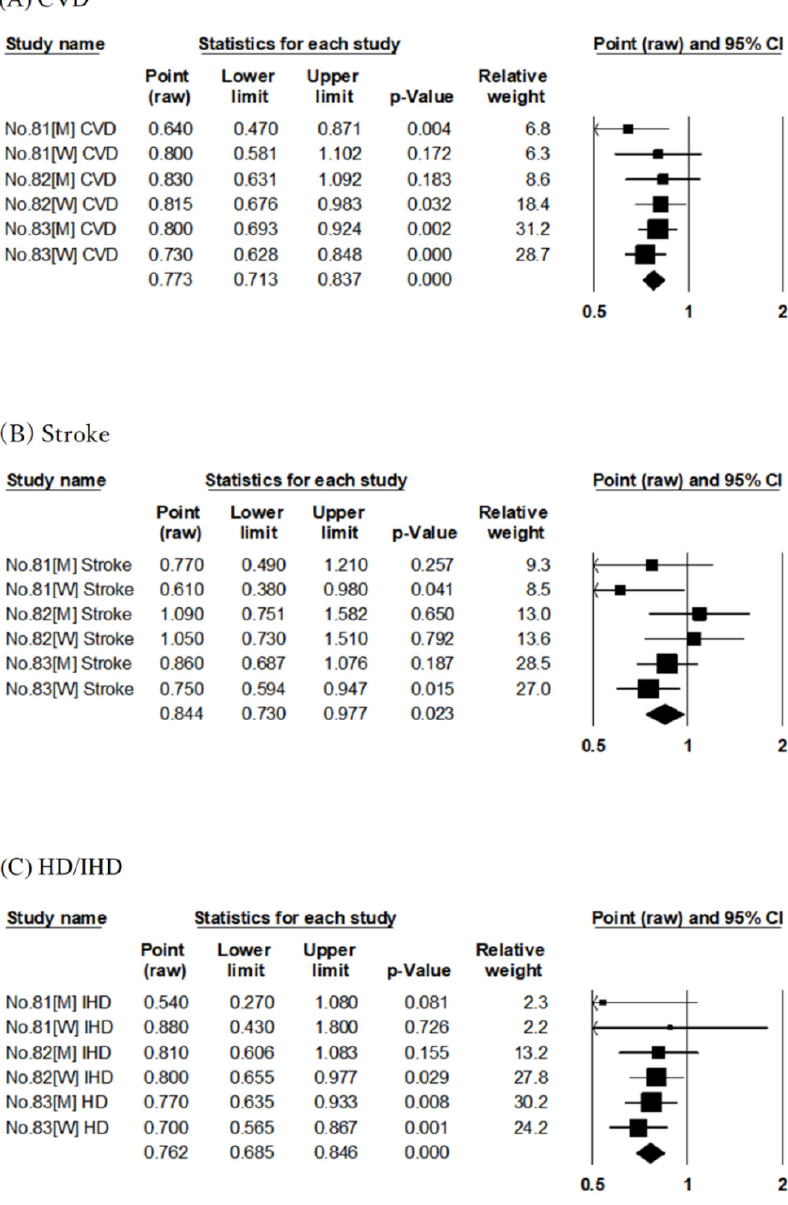
Figure 9. Meta-analysis of dietary fiber consumption and mortality risk. ( A – C ) show the association between dietary fiber consumption and CVD, stroke, and HD/IHD mortality risk, respectively. The area of each square is proportional to the study weight. Horizontal lines represent 95% confidence intervals. Diamonds represent pooled estimates from inverse-variance-weighted random-effects model. The number given in the study name indicates that of the cited reference [81–83]. CVD; cardiovascular disease, HD; heart disease, IHD; ischemic heart